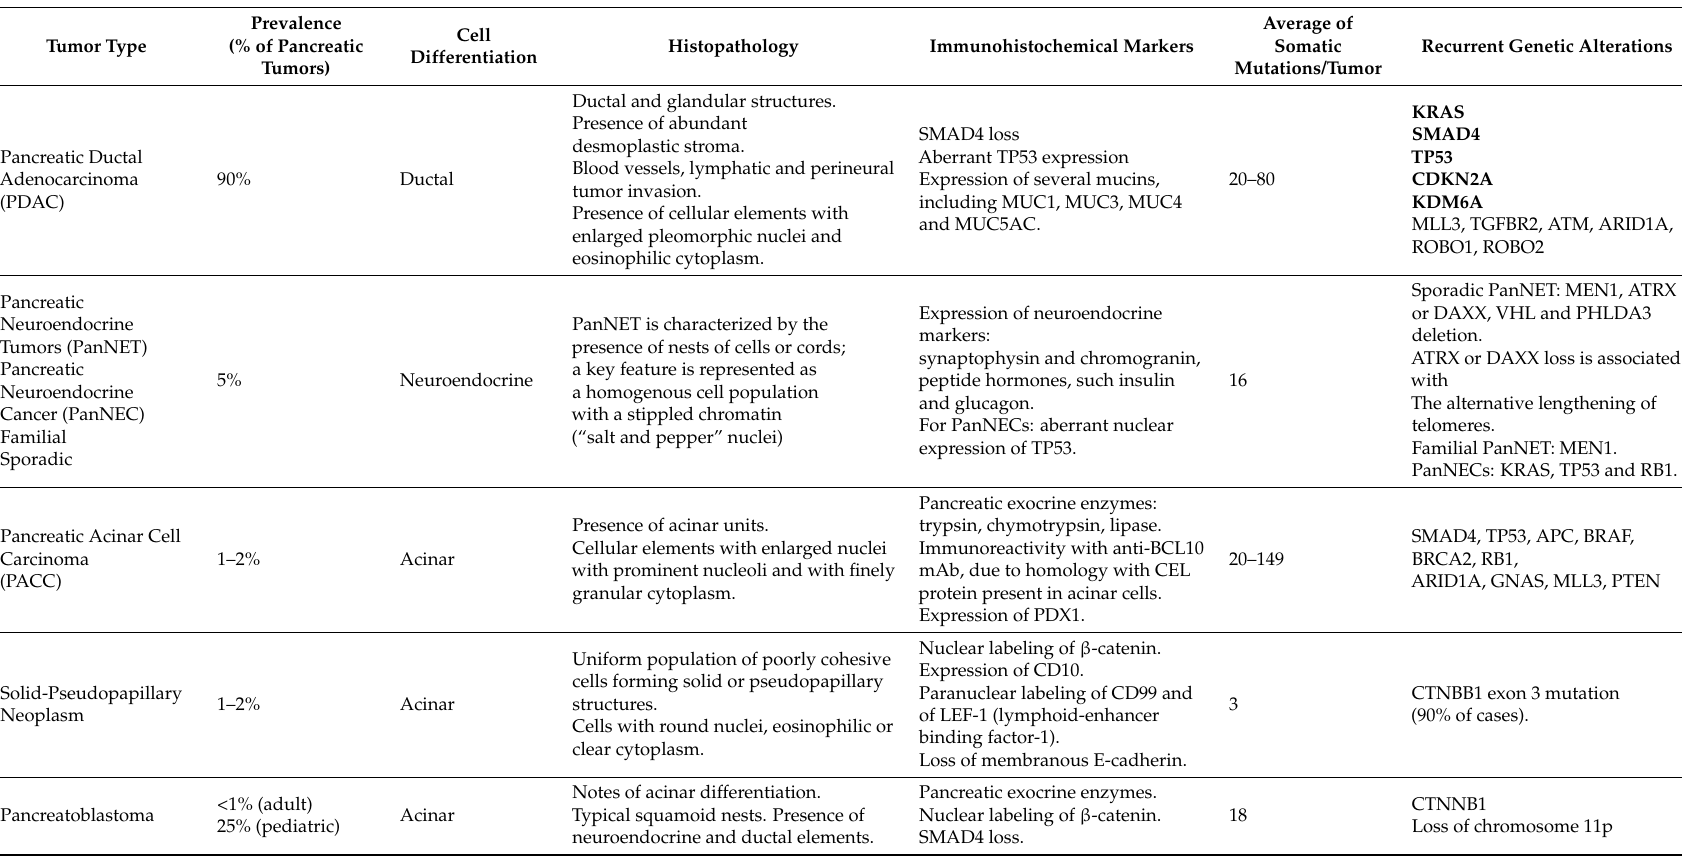
Table 1. Histological and molecular properties of the main types of pancreatic tumors. The most recurrent genetic alterations observed in PDAC are marked in bold.